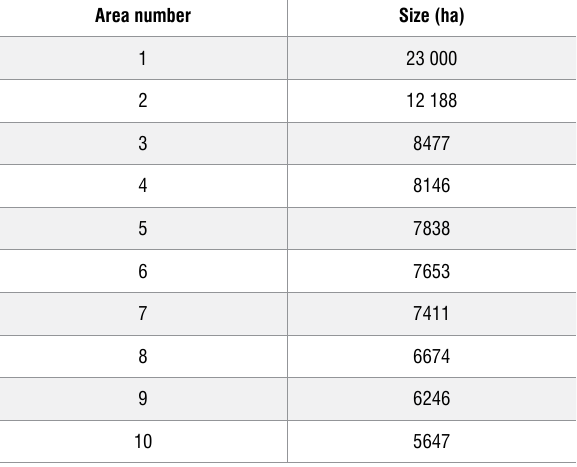
Table 3: Sizes of the 10 largest areas identified as potential target areas for conservation within the Grassland Biome of South Africa